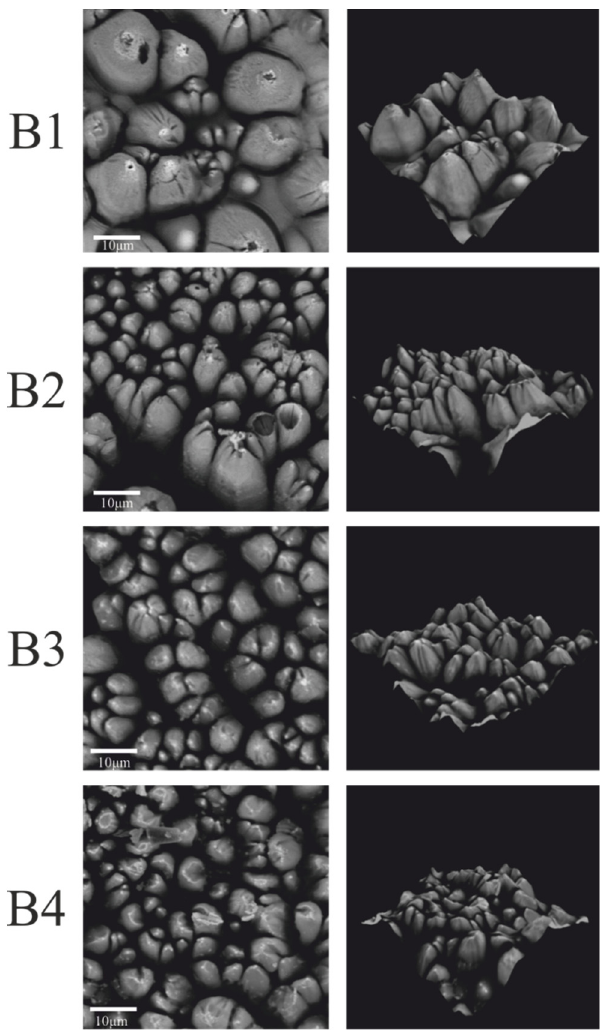
Figure 5. SEM images of B1–B4 coatings (N = 500, scale—10 μ m). Table 2. The content of Cu, O, C and Sb atoms in the surface layer of the tested coatings irradiated with a different number of laser